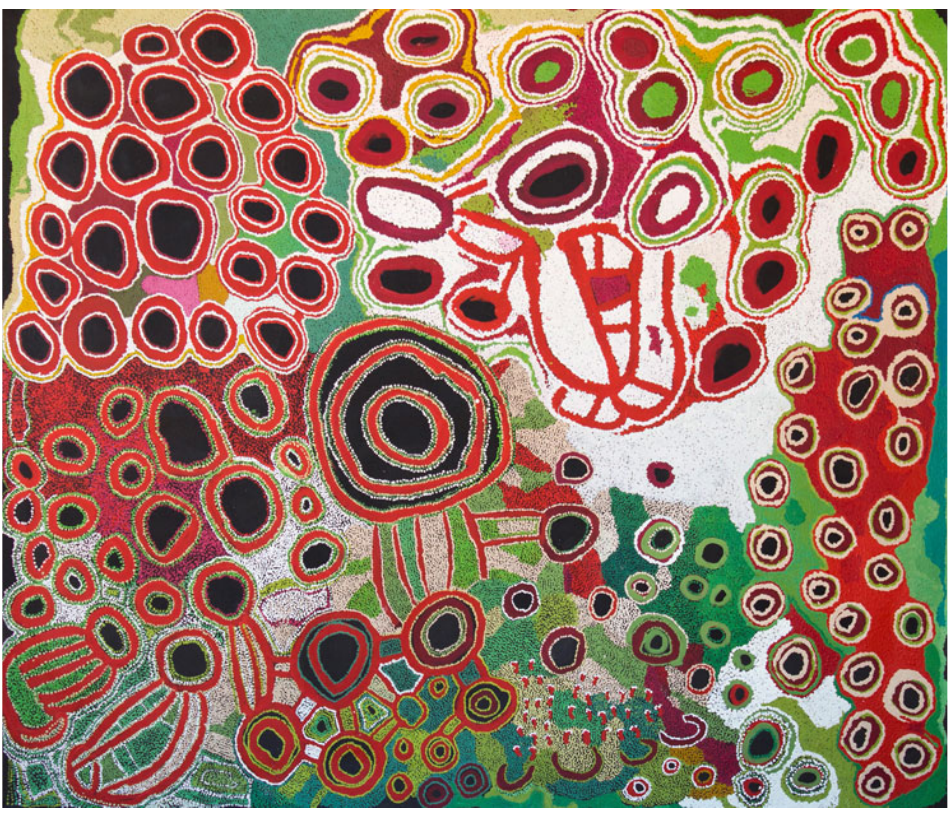
Kunmanara (Anne Ngantiri) Hogan, Tjaruwa Woods, Yarangka Thomas, Estelle Hogan, Ngalpingka Simms and Myrtle Pennington, Kungkarangkalpa , 2013, acrylic on linen, 197 x 223 cm. British Museum (photo: courtesy Spinifex Arts Project and Redot